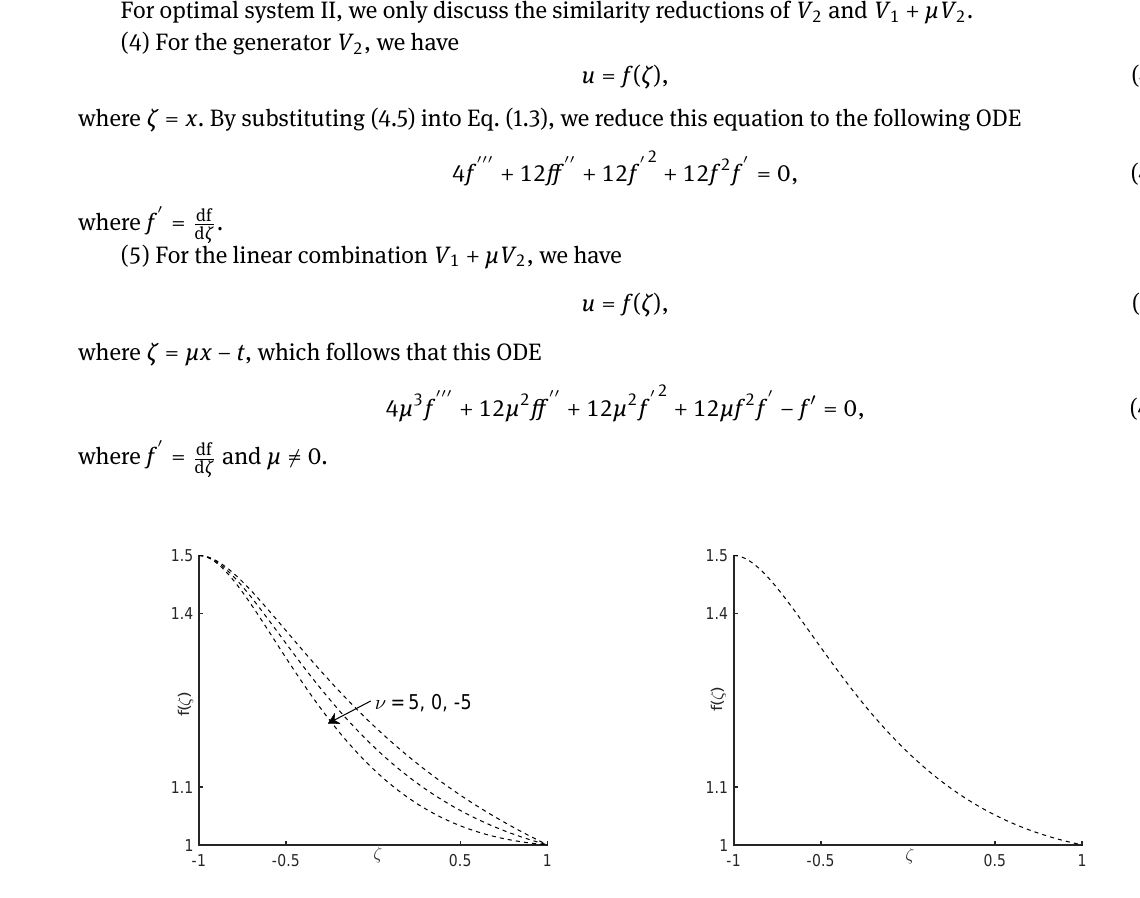
Figure 1: The graph of f ( ζ ) given by Eq. (4.2) as ν takes −5, 0, 5 .